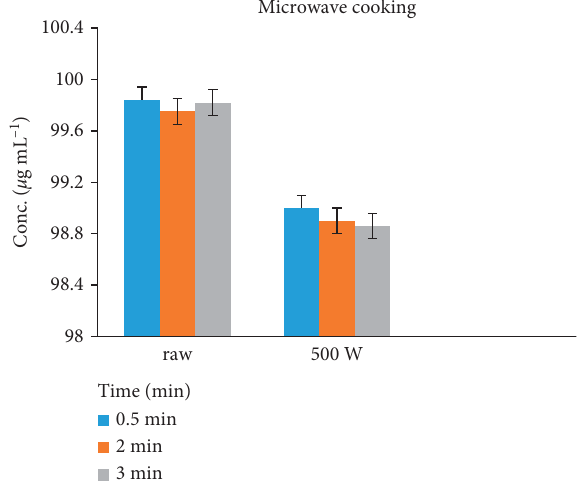
Figure 6: The effects of microwave cooking on the depletion of Amox residue within different temperatures and times from chicken tissue.